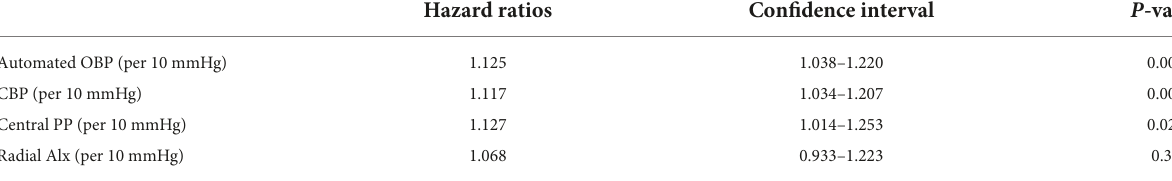
TABLE 3 Multivariable Cox models of relation of each blood pressure variables to primary endpoints. Hazard ratios Confidence